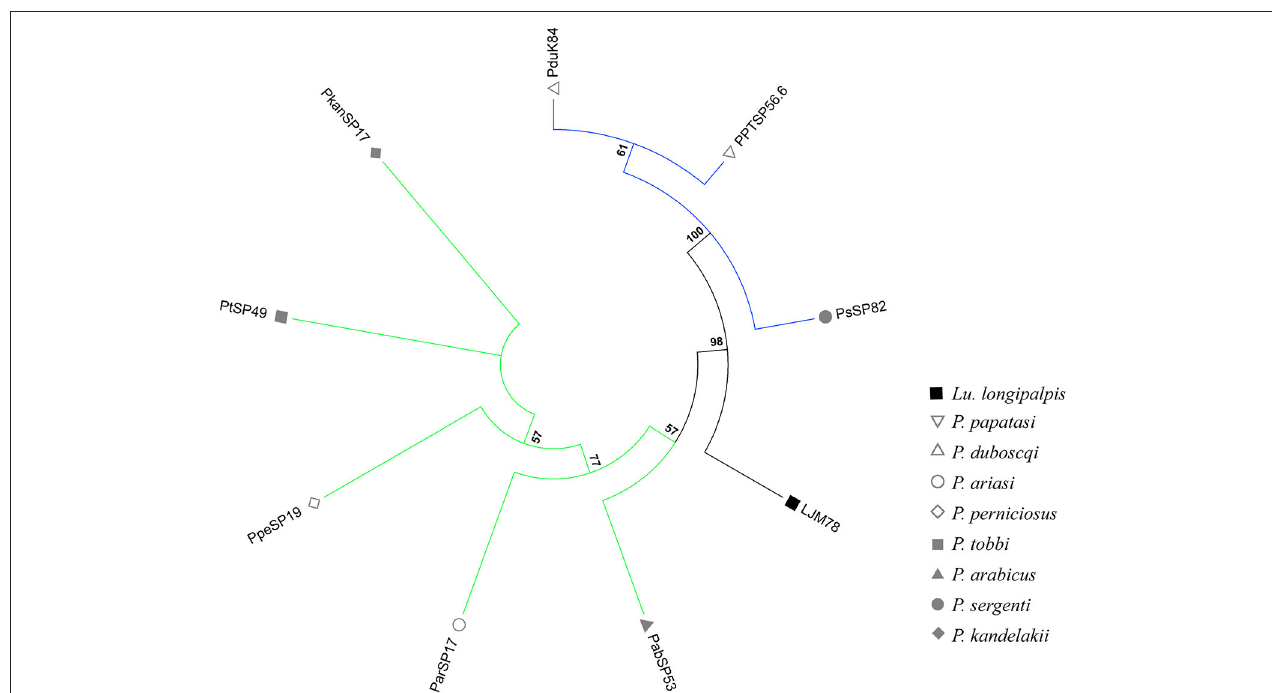
FIGURE 1 | Phylogenetic analysis of ParSP17 protein family. The evolutionary history was inferred by using the Maximum Likelihood method based on the Le Gascuel matrix-based model ( Gomes et al., 2008). Sand fly species are indicated by the different symbols in the legend on the right. Tree branches were color-coded so as to represent specific taxon: Green color represents the Larroussius and Adlerius subgenera; Blue color points to proteins of the Phlebotomus and Paraphlebotomus subgenera; and Black color indicates the proteins belonging to New World sand flies. Although the PduK84 sequence is illustrated here, it was not included in further analyses because it is